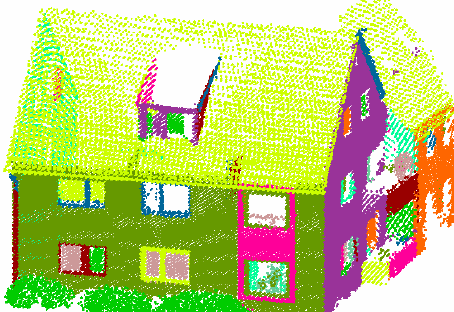
Figure 4. Segmentation results – Case 1 (the different features are denoted by different colours)